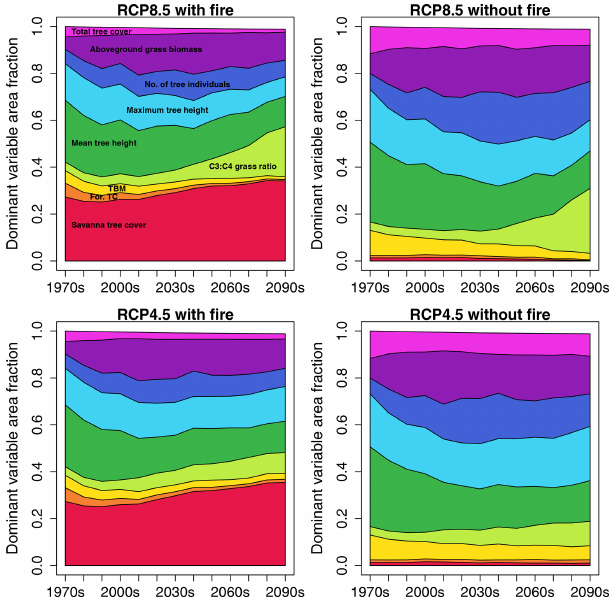
Figure 7. Fractions of African area where a given variable is the dominant variable defining residual distance between CDPs, illus- trated as time series stacks for the four scenario pairings between CDPs. Variable color coding is annotated in the panel for RCP8.5 with fire. The color coding for the variables is identical in all four